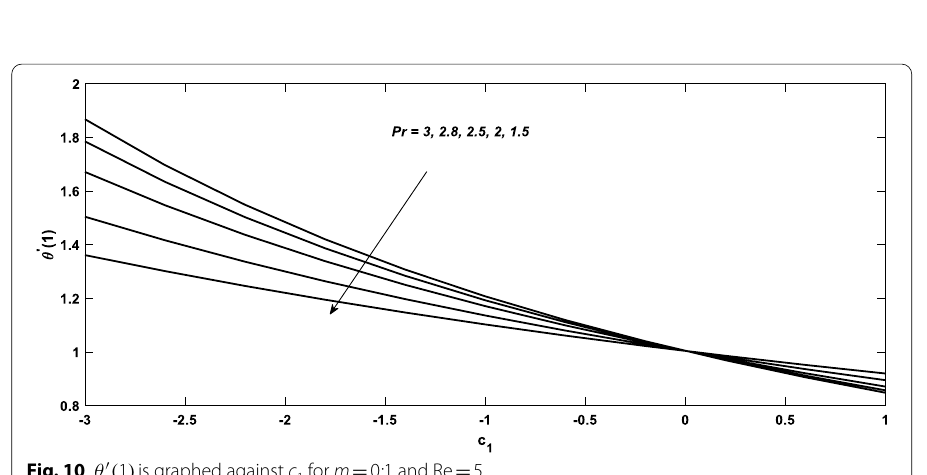
Fig. 10 θ ′ ( 1 ) is graphed against c 1 for m